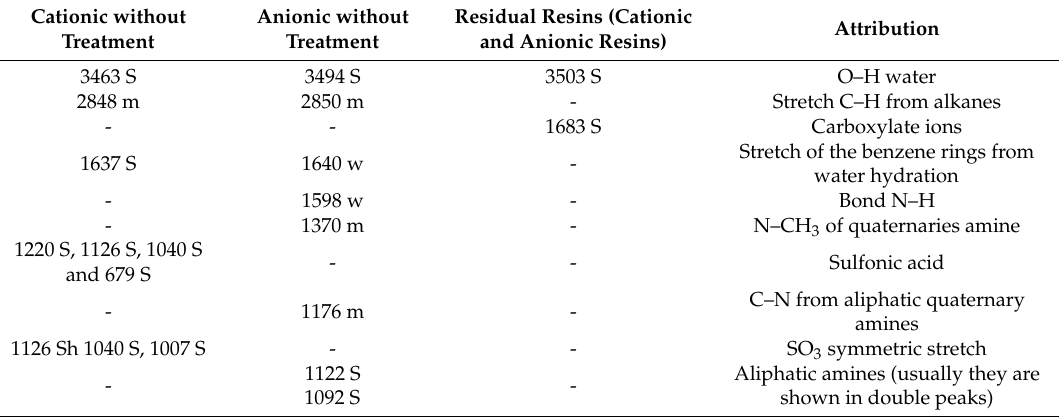
Table 4. Summarized infrared spectrum analysis of the cationic and anionic resins without treatment and the residual resins after Fenton’s